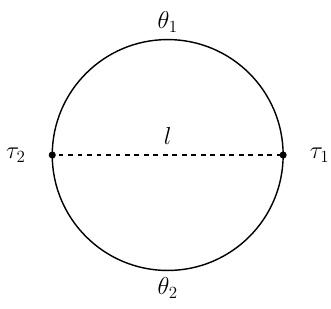
Figure 13. A skeleton chord diagram for the 2-point